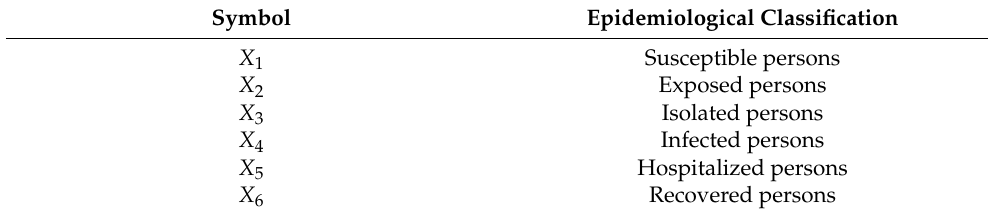
Table 2. Epidemiological meaning of the deterministic parameters appearing in (1). Parameter Epidemiological Meaning Unit r The natural intrinsic growing rate of X A The carrying amplitude of X B 0 The propagation ratio between X B 1 The maximal efficient contact rate between X 1 and X 4 days B 2 The maximal efficient contact rate between X B (cid:63) 1